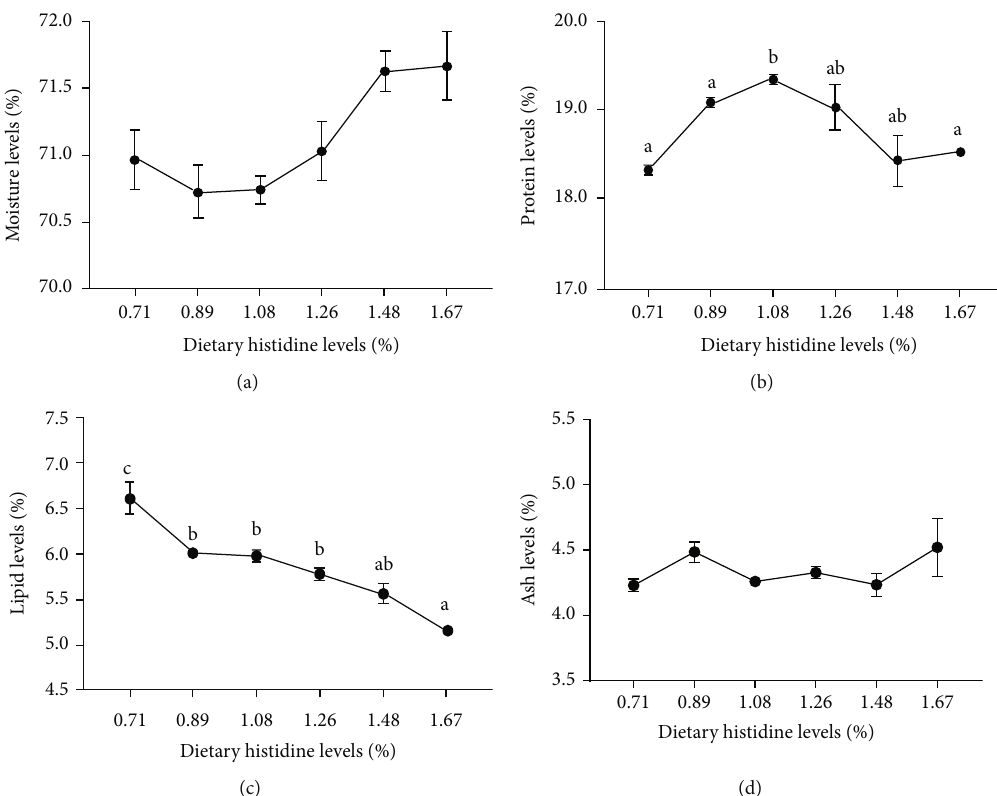
Figure 2: The whole body composition of juvenile largemouth bass fed with di ff erent levels of dietary histidine. Data are expressed as means with S.E.M.; value with di ff erent superscripts are signi fi cantly di ff erent ( P < 0 : 05